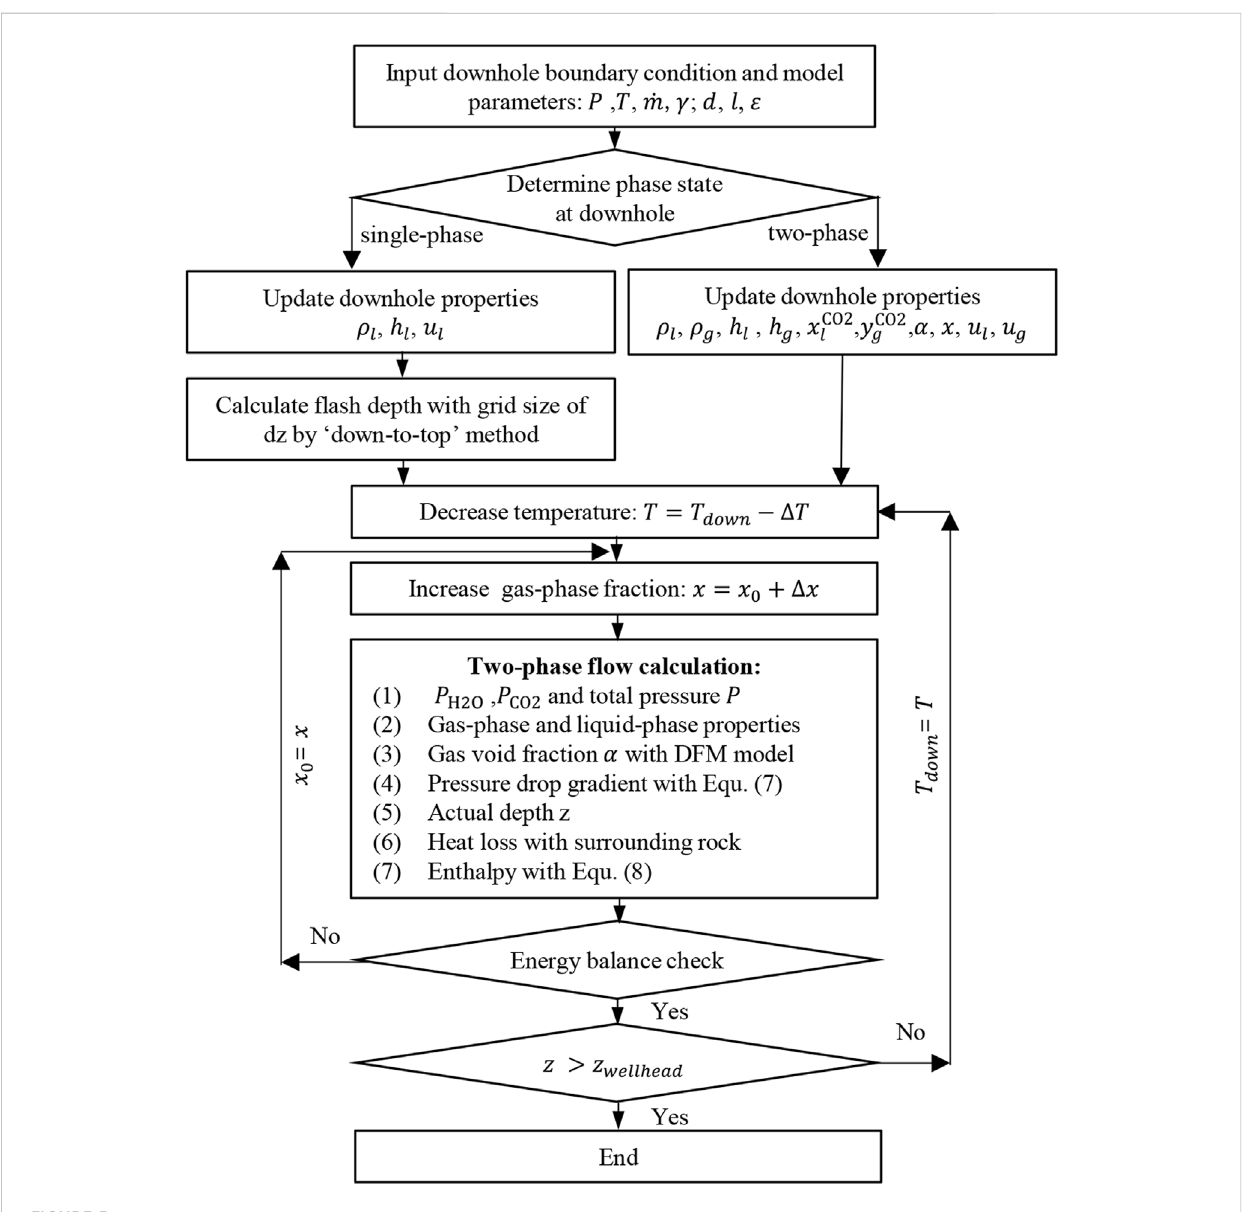
FIGURE 5 Flowchart of